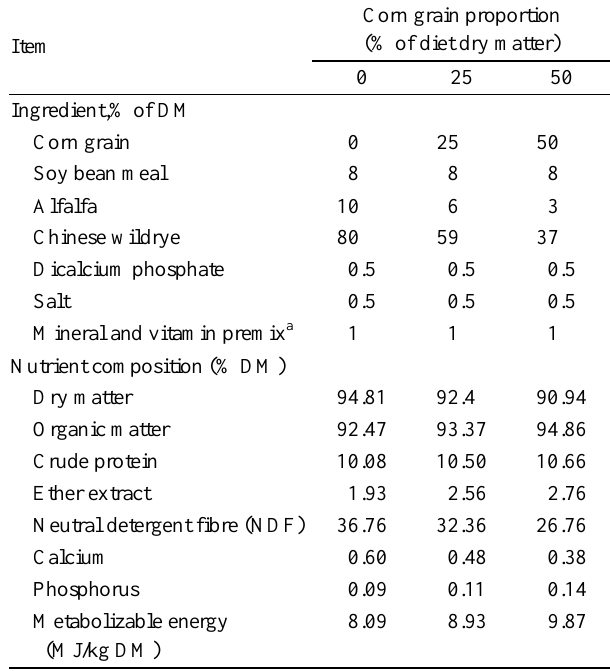
Table 1. Composition and ingredients of experimental diets